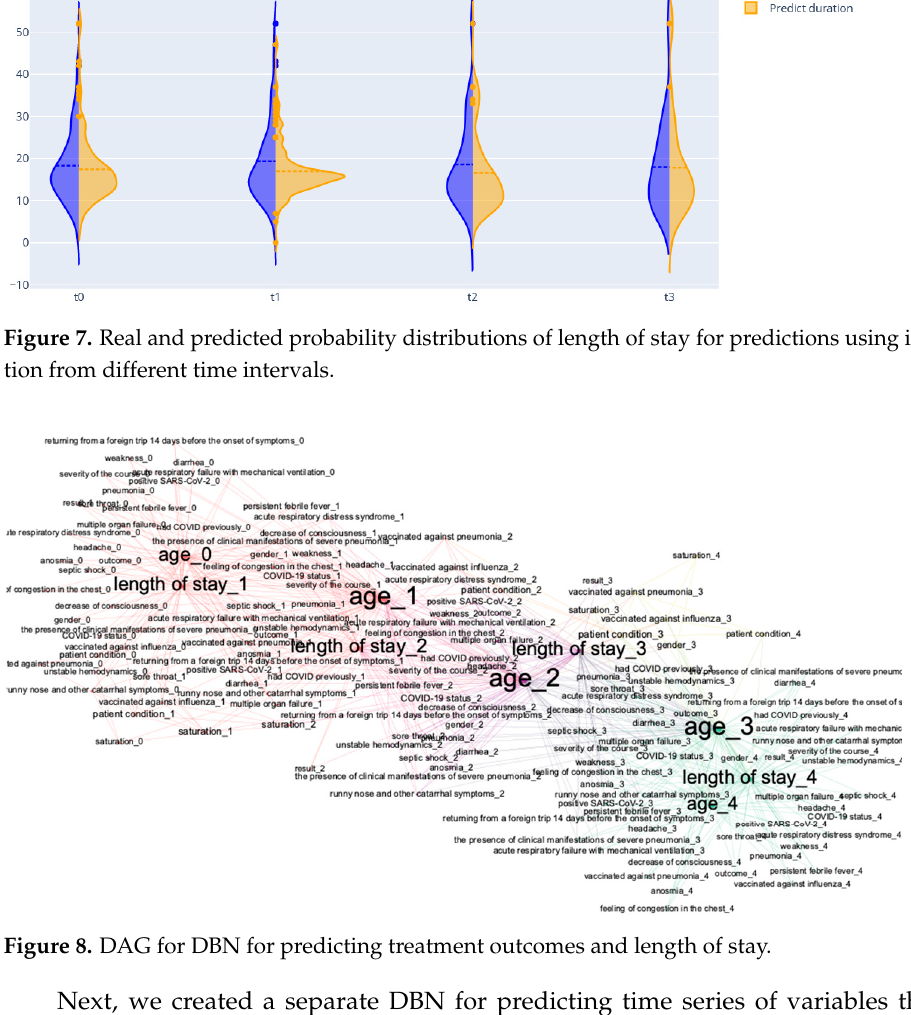
Figure 8. DAG for DBN for predicting treatment outcomes and length of stay.